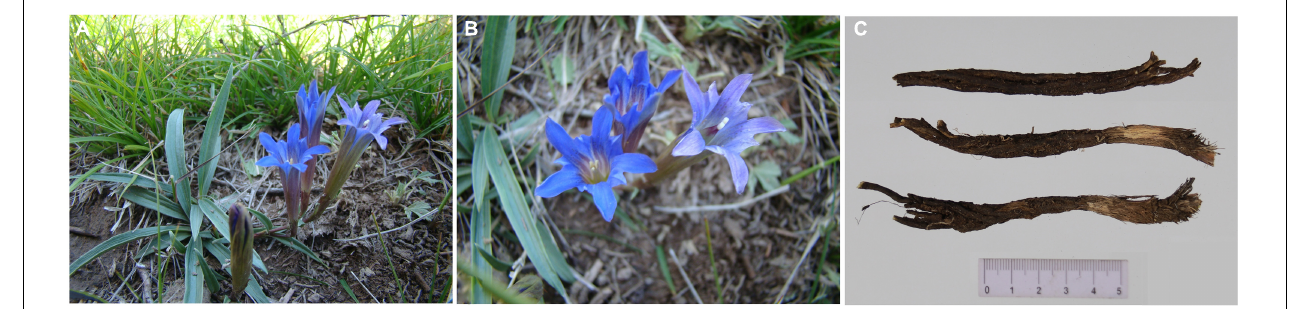
FIGURE 1 | Wild Gentiana dahurica (A) ; flowering G. dahurica (B) ; dried roots of G. dahurica (C)